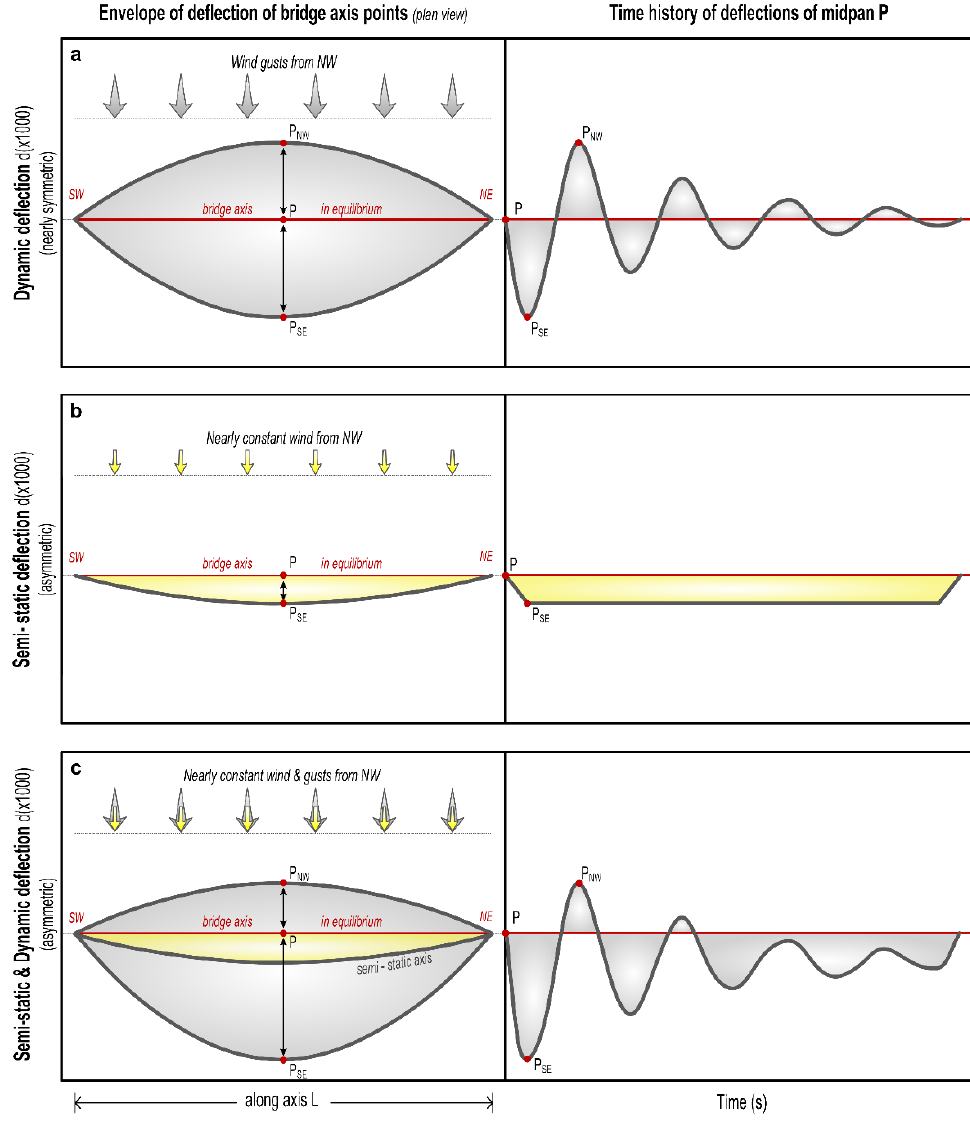
Figure 10. Conceptual model to explain asymmetric bending of the bridge main axis (and hence increased damage), as a result of loading by dominant northerly winds producing a combination of semi-static and dynamic deflections. Inferred from observations in the Humber Bridge (Figure 9) and from results of monitoring surveys. Left column indicates the envelope of all possible positions of the deforming bridge axis, right column the time series of deflections of the middle point. Upper row: Dynamic loading produces essentially symmetric deflections relative to the main bridge axis (when in equilibrium position). Middle row: Semi-static loading produces asymmetric deflections (in yellow). Lower row: The combination of semi-static and dynamic loading (gusts superimposed on nearly steady-state wind load) produces asymmetric deflections and strong stresses along the southern sides of the beams. Accumulation of such oscillations produced fatigue-induced cracks (longitudinal splits). This pattern corresponds to the deformation of the midspan of the bridge, 26.5 m long (see Figure 1).